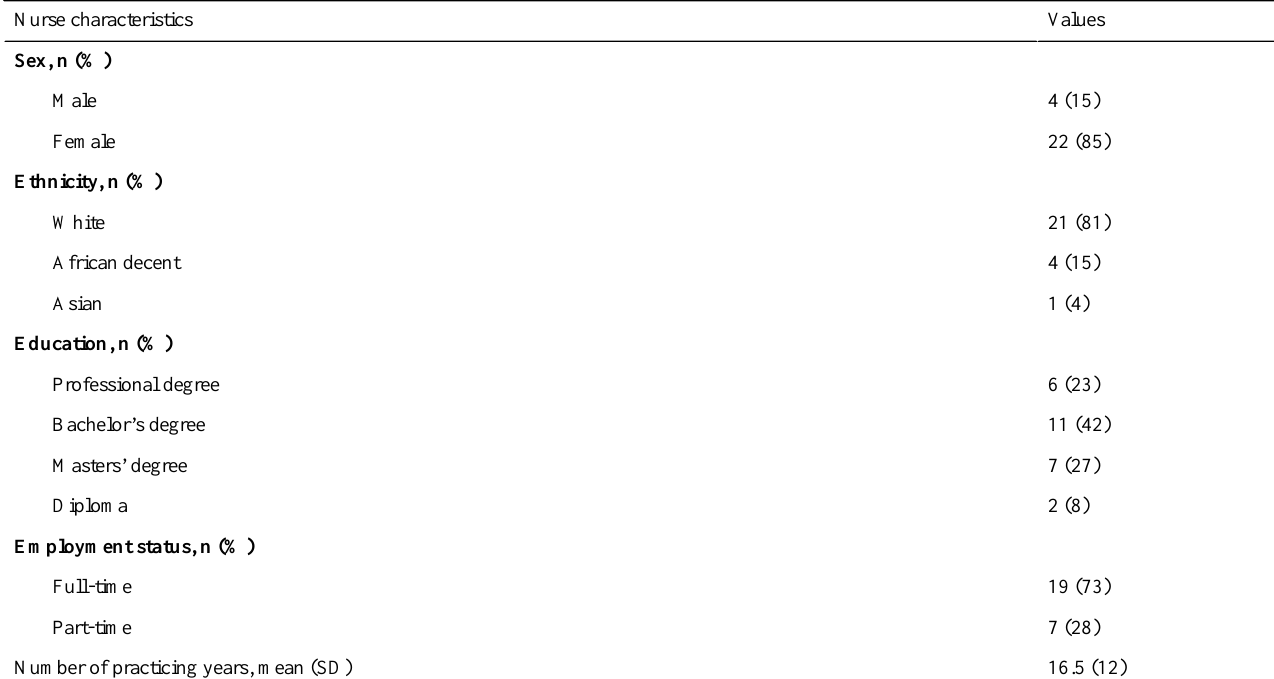
Table 1. Nurse participant characteristics